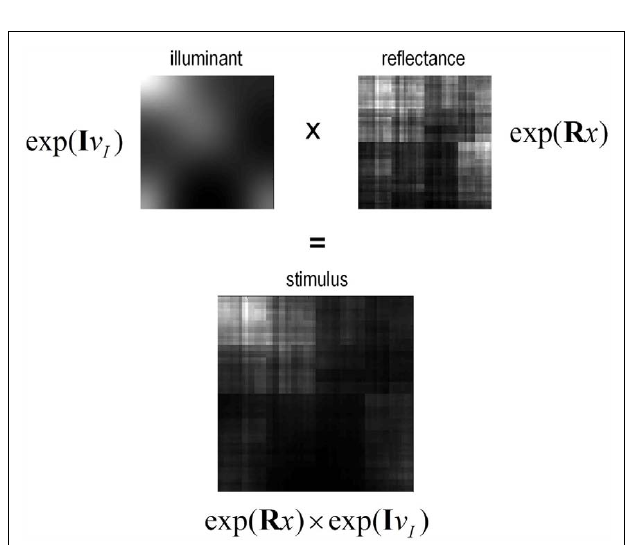
FIGURE 3 |The generative model: the generative model employed in this paper models illuminance as a discrete cosine function and reflectance as a Harr wavelet function with peripheral high frequency wavelets removed. In addition, illumination is allowed to change quickly over time, whereas reflectance varies more slowly.This is achieved by making the coefficients on